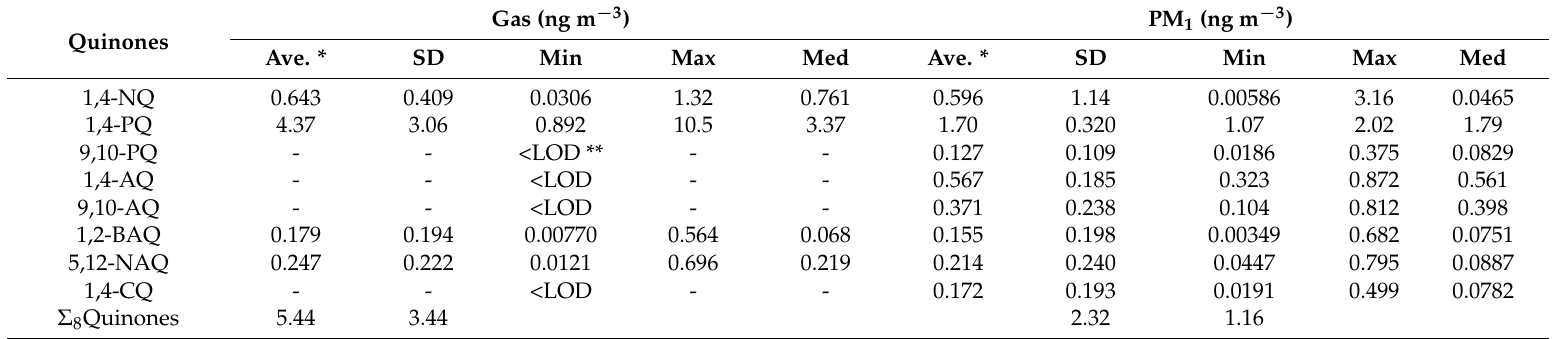
Table 8. Average ambient levels of quinones in the gas and PM 1 phases at the CEN and TLA sites in the